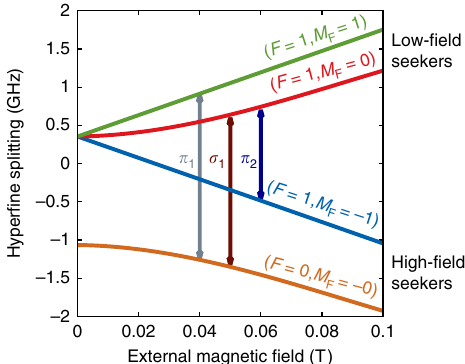
Figure 1 | GS-HFS in hydrogen. The Breit–Rabi diagram shows the energy levels in ground-state hydrogen as a function of the strength of an external magnetic field. The four hyperfine states separate into a singlet state and a triplet state, which exhibit different Zeeman shifts. The states with a positive or negative slope are named low- or high-field seekers, respectively. Three possible hyperfine transitions between lfs and hfs are denoted by arrows, the s 1 -transition occurs between the states ( F ¼ 1, M F ¼ 0) and ( F ¼ 0, M F ¼